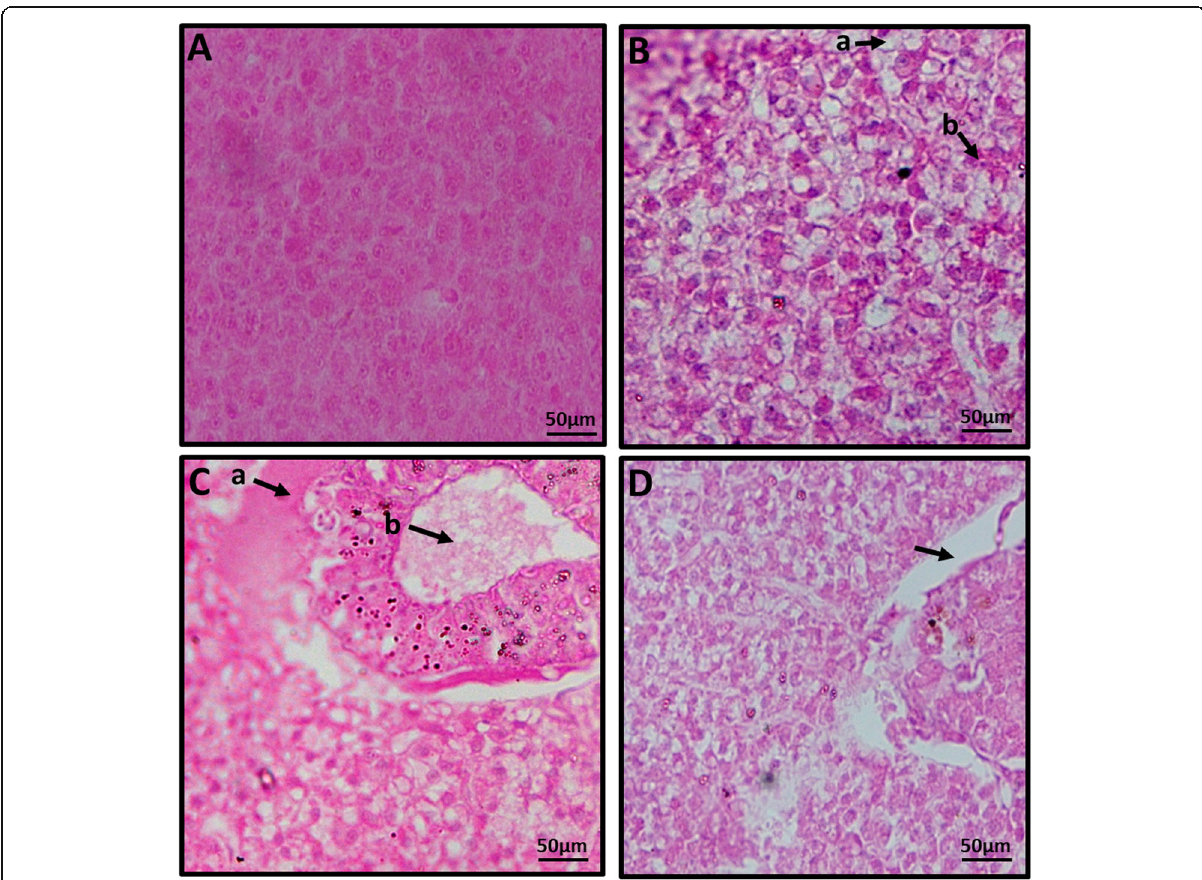
Fig. 3 Photomicrographs of liver of Heteropneustes fossilis after 7-day exposure to 0.015 ppm Envoy 50 SC. a Control — normal regular and systematic arrangement of hepatocytes were found; b cytoplasmic vacuolation (a) and nuclear hypertrophy (b); c hemorrhage (a) and pyknotic area (b); and D vacuolation were